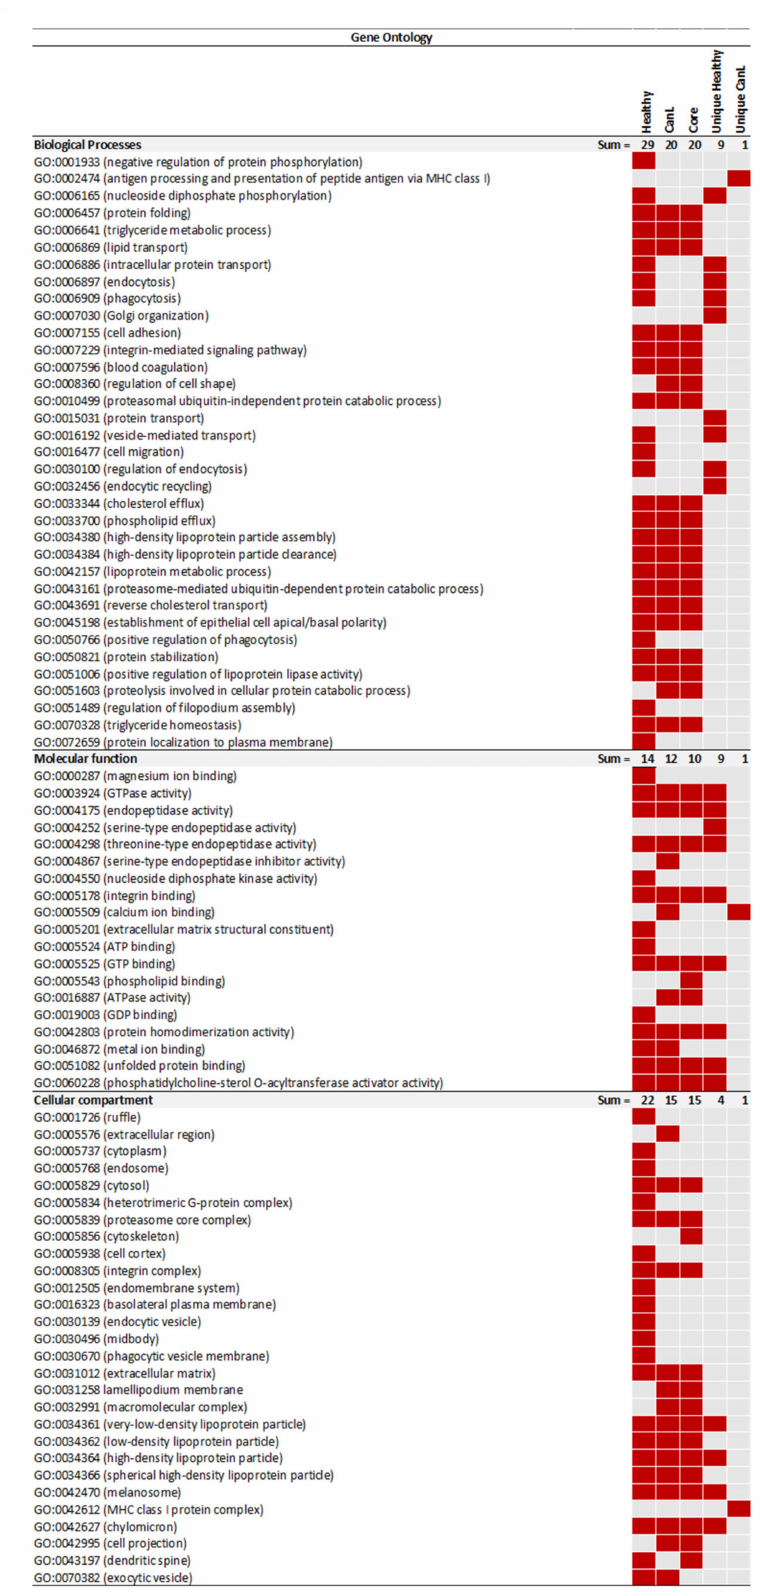
Figure 4. Gene ontology (GO) enrichment analysis of the proteins in the Healthy dogs EVs, CanL EVs, in the core proteome, in the proteins unique to Healthy EVs and proteins unique to CanL EVs. GO enrichment analysis shows terms significantly enriched for biological processes, molecular function and cellular